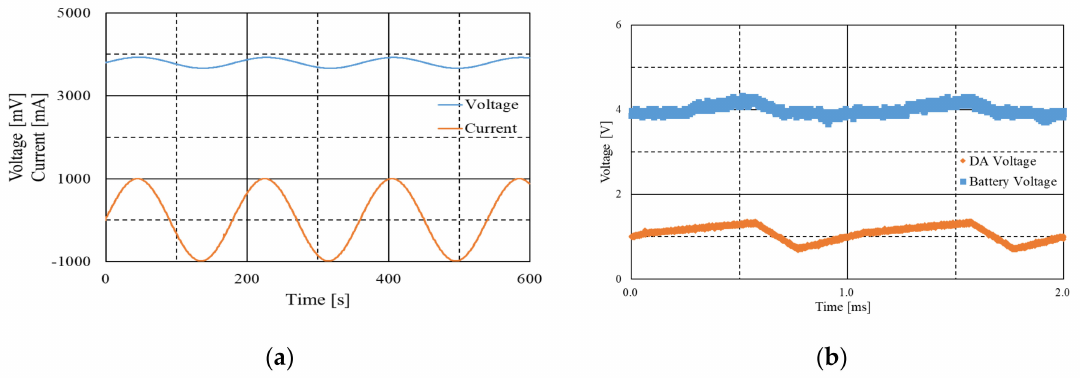
Figure10. Arbitrarywaveformcharging / discharging(Li-Ion1cell): ( a )sinusoidalwaveform, ( b )another example of arbitrary waveform during